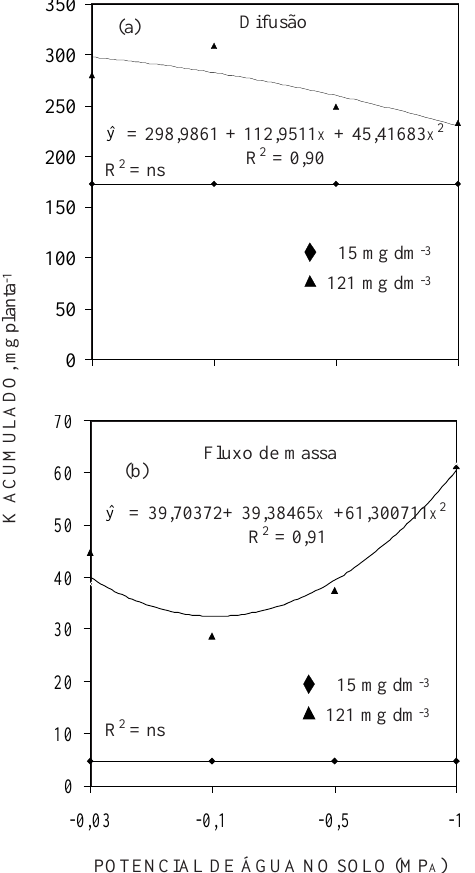
Figura 3. Conteúdo de potássio em plantas em de- corrência do transporte por difusão (a) e por fluxo de massa (b), considerando a disponibili- dade de água no solo e a aplicação de